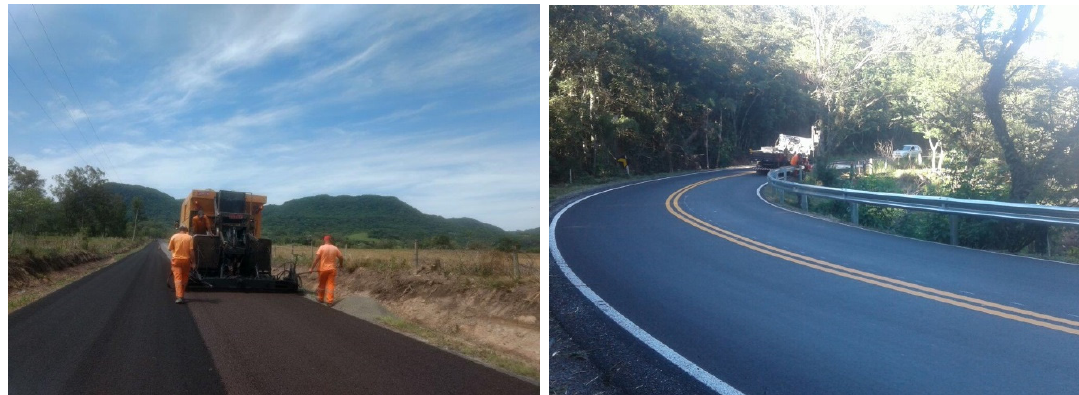
Figure 4. Microsurfacing on VRS ‐ 804 road during and after construction.